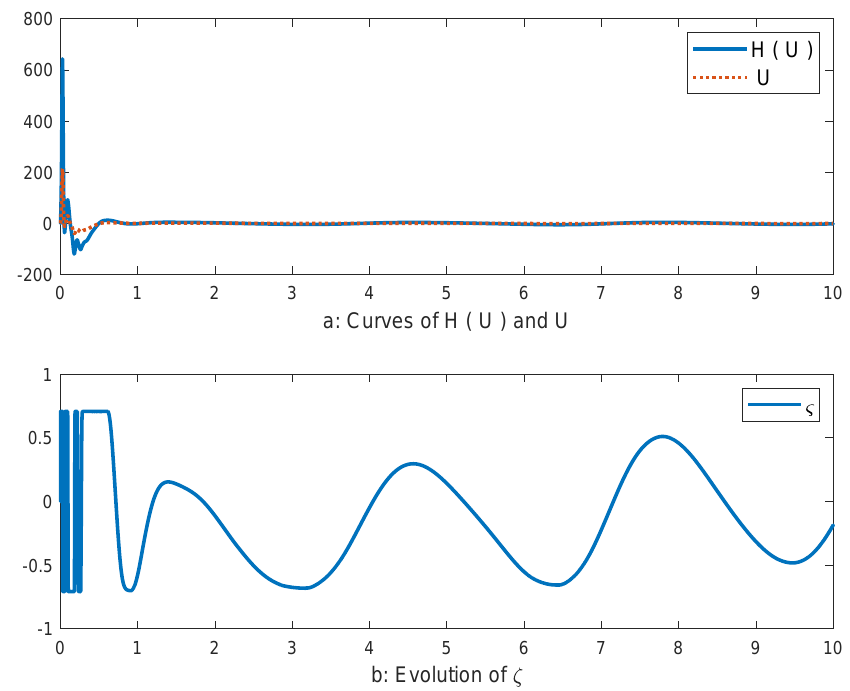
Figure 9. The control input and hysteresis nonlinearity.